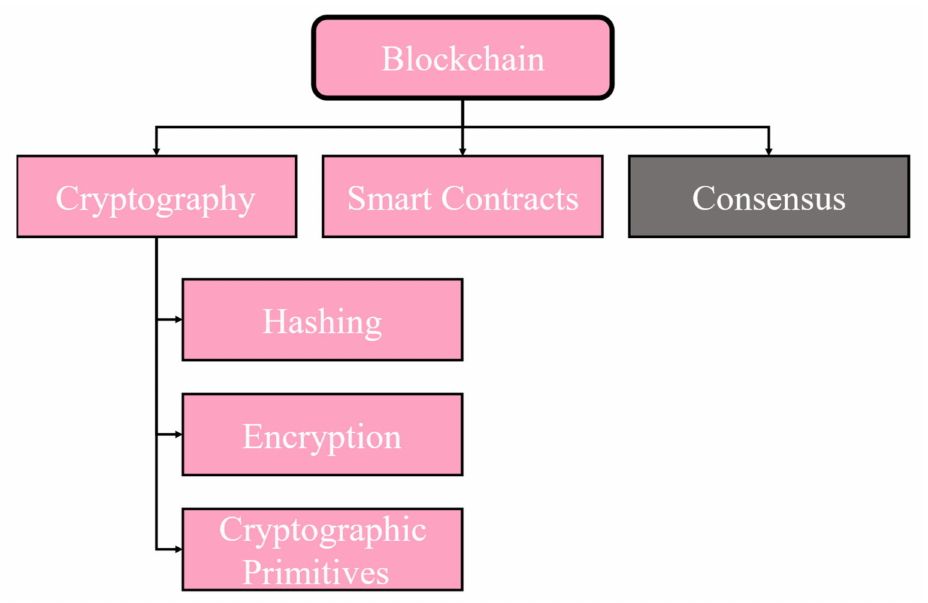
Figure 2. Blockchain components for privacy